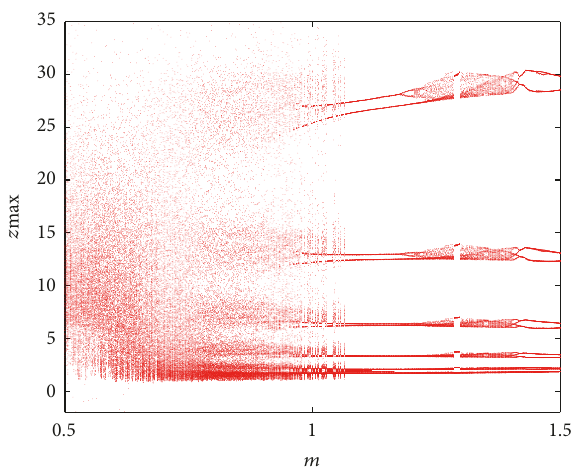
Figure 1: Bifurcation diagram of system (2) without equilibria versus parameter 𝑚 in [0.5,